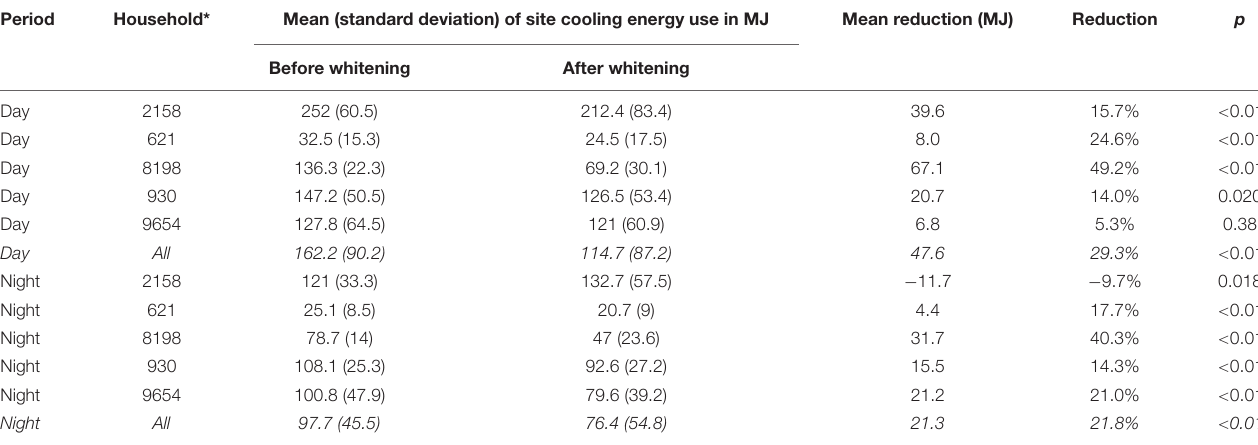
TABLE 4 | Household-level comparisons for the treated